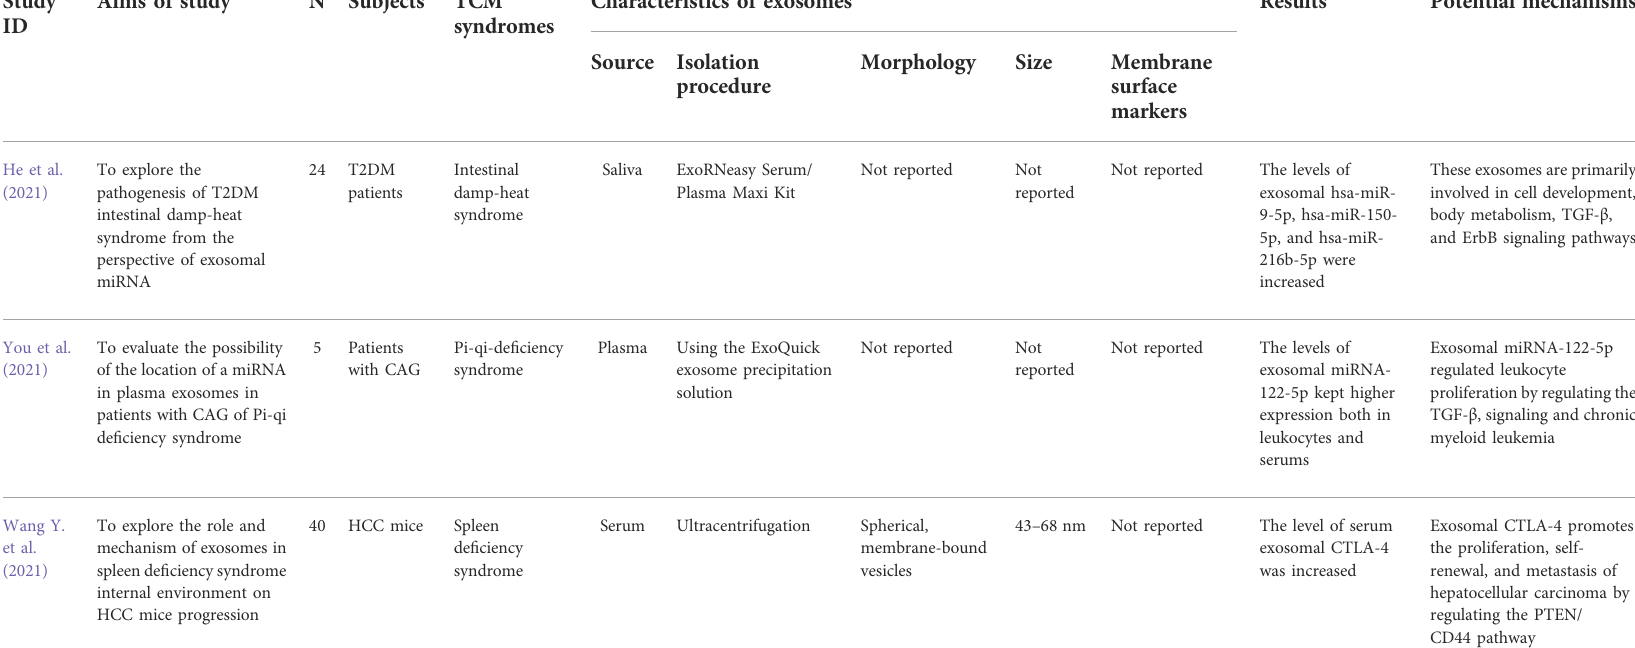
TABLE 4 The interplay between Exosomes and traditional Chinese medicine